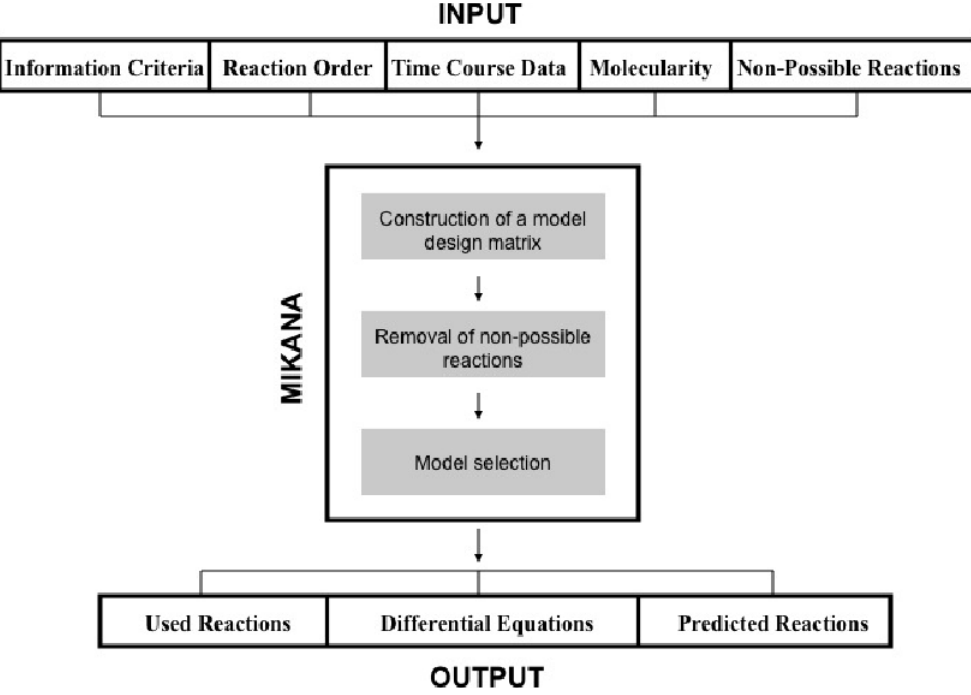
Figure 6. Input, Output and the main processes of MIKANA. MIKANA’s input is composed of a time course data and a set of reactions known to be absent in the final solution set. There are three different types of information criteria: (i) Empirical; (ii) Akaike; and (iii) Bayesian. The user can also select between first– or second–order reactions (Reaction Order) and a maximum molecularity (one or two molecules per chemical species per reaction) to work with. The core process of MIKANA is the construction of a model design matrix with all possible elementary chemical reactions. Other processes include the exclusion of specified reactions and a model selection process. The output of MIKANA consists of a set of elementary reactions used in the model selection process and a set of predicted reactions from which we obtain the differential equations.